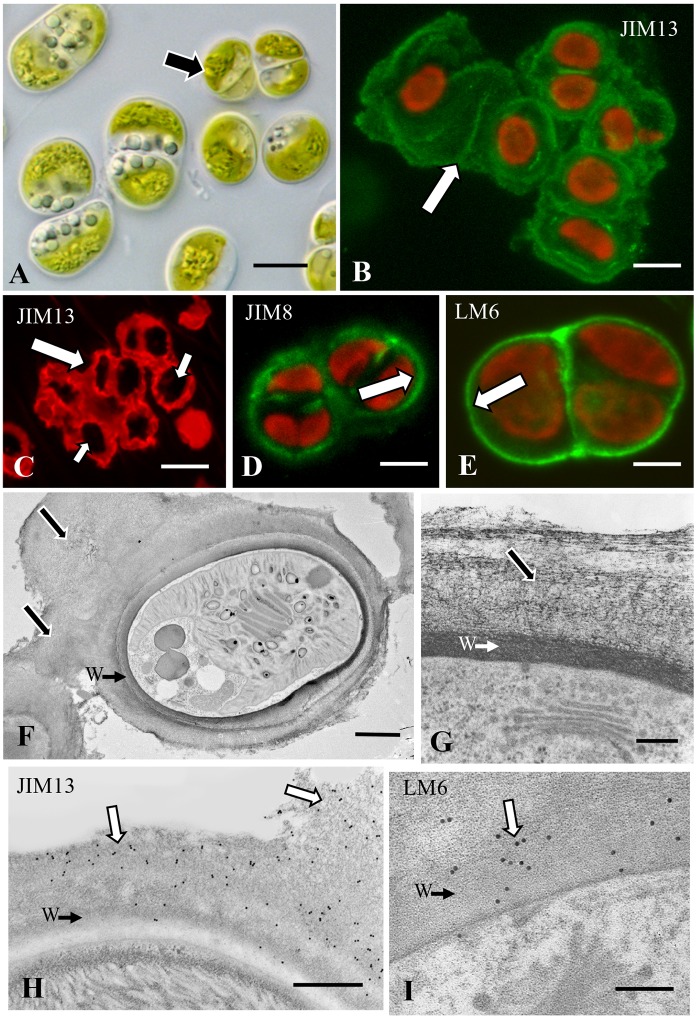
Chlorokybus: (A) DIC image of Chlorokybus showing unicellular or sarcinoid packet form (arrow). Bar 6.5 μm. (B) JIM13 immunofluorescence demonstrating labeling in an extracellular sheath (arrow). Bar 6.0 μm. (C) JIM13 immunofluorescence CLSM image showing the extensive extracellular sheath both around and between cells (large arrow). The cells are the dark zones within the packet sheath (small arrows). Bar 9.0 μm. (D) JIM8 labeling of the cell wall (arrow). Bar 7.0 μm. (E) LM6 labeling of the cell wall (arrow). Bar 4.5 μm. (F) TEM image of a cell in a sarcinoid packet. Note the cell wall (CW→) surrounded by the extensive extracellular sheath (arrows). Bar 4 μm. (G) Magnified TEM image of the ECM showing the cell wall (CW→) and extracellular sheath (arrow). Bar 500 nm. (H) JIM13 immunogold labeling of the extracellular matrix (ECM, arrows), labeling of the cell wall very limited (CW→). Bar 700 nm. (I) LM6 labeling of the cell wall (arrow) and interface of the wall (W→) with the ECM. Bar 800 nm.